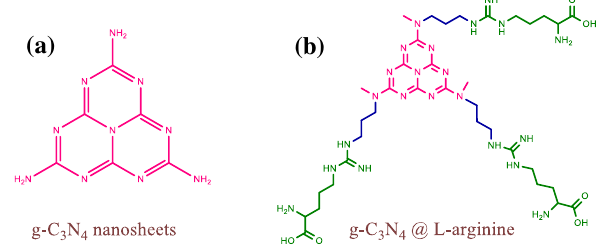
Figure 2. Nanosheets g-C 3 N 4 , ( a ) and g-C 3 N 4 @l-arginine ( b ).